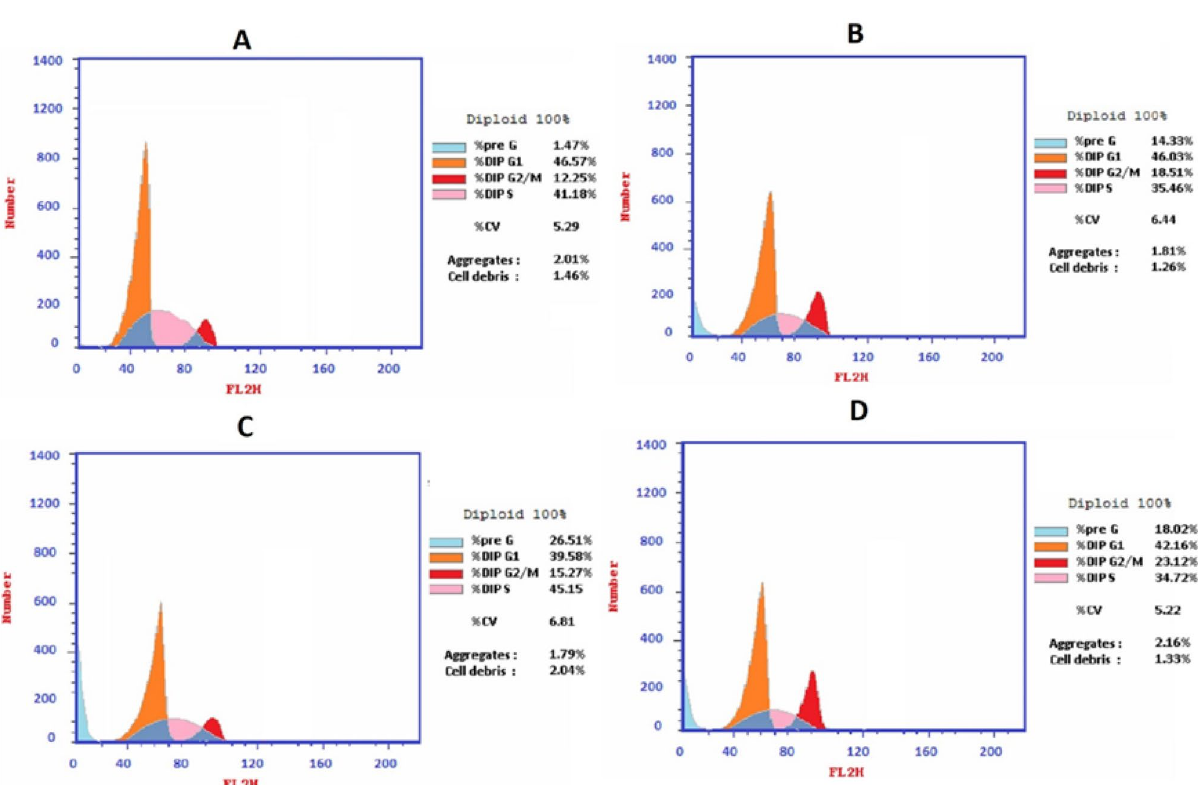
Figure 6. The effect of the FLV-PL-ALA-MEL over the phases of Caco2 cell cycle. With a view to making more than one comparison, we used the Tukey post hoc test. *Significantly different versus control (p < 0.05). # Significantly different versus Plain formula (p < 0.05). $ Significantly different versus FLV-R (p < 0.05). ( a ) control, ( b ) Plain formula, ( c ) FLV and ( d )